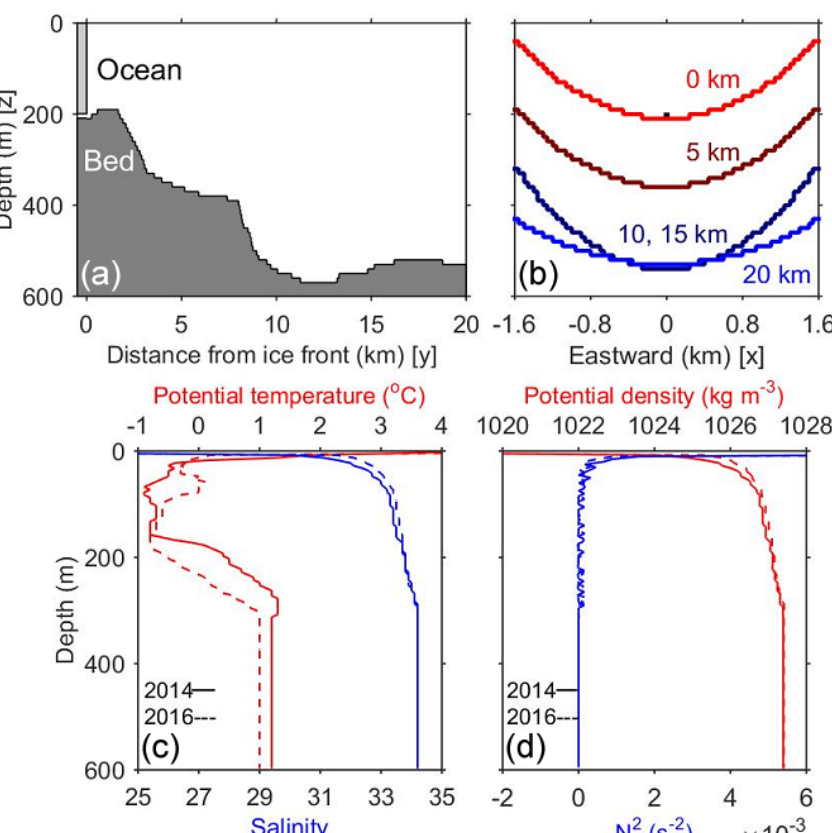
Figure 9. Numerical model settings. (a) Ocean depth along the centerline of Bowdoin Fjord (from north to south). The space between the glacier and the sea bed indicates a 10m high subglacial drainage conduit. (b) Depth across the fjord (from west to east) at 0, 5, 10, 15, and 20km from the ice front. The box indicates the subglacial drainage conduit at the center of the fjord (40m wide × 10m high; 400m 2 ). Initial vertical profiles of (c) potential temperature, salinity, (d) potential density, and the square of Brunt–Väisälä frequency ( N 2 ) computed from (c) .